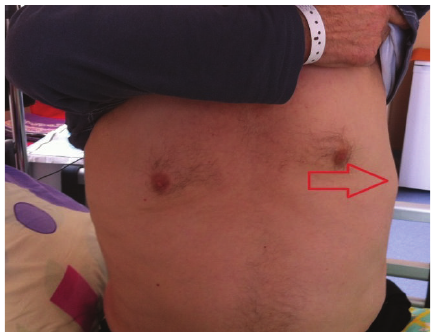
Figure 4: Thoracic inspection of patient.